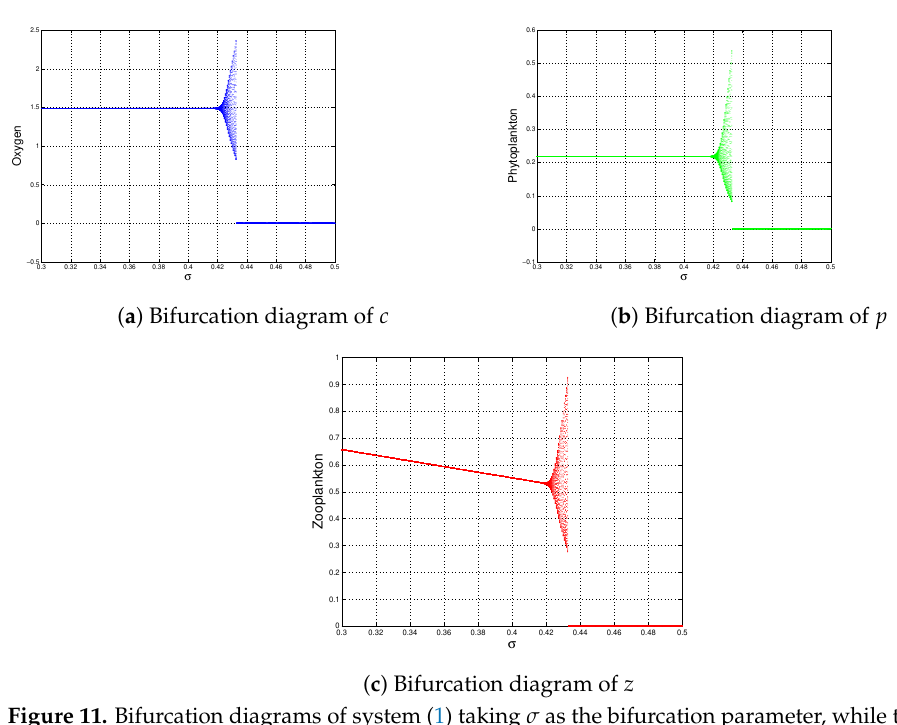
Figure 11. Bifurcation diagrams of system (1) taking σ as the bifurcation parameter, while the others remain unchanged, as in Figure 6. Here, (cid:98) E ( (cid:98) c , (cid:98) p , (cid:98) z ) is stable when σ ∈ ( 0.0, σ [ H ] = 0.4216 ) and unstable with a periodic solution when σ ∈ ( 0.4216,0.4363 ) . When σ ( mortality rate of phytoplankton ) > 0.4363 = σ [ tc ] , the system dynamics change abruptly, resulting in the depletion of oxygen and the extinction of plankton in the marine ecosystem.